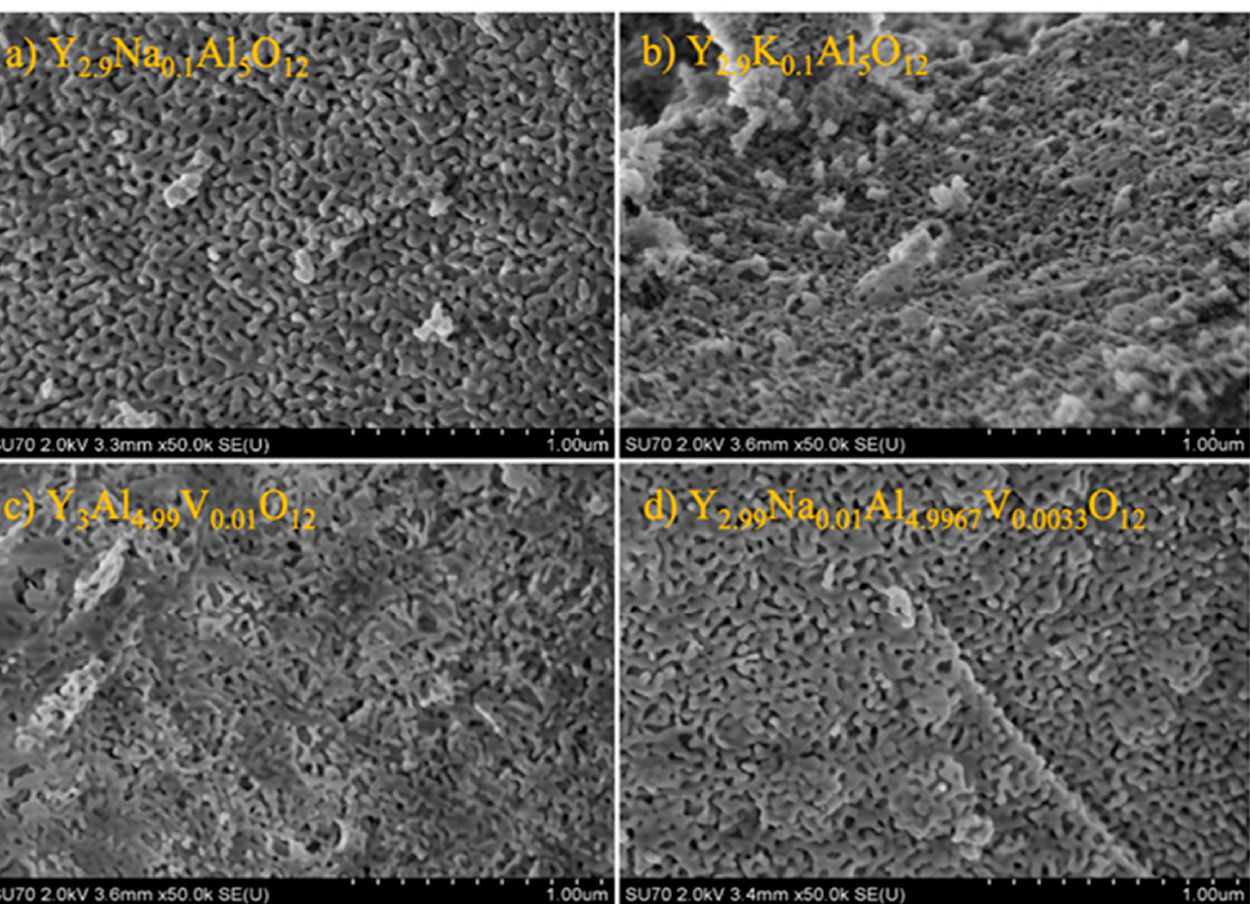
Figure 3. SEM micrographs of the Y 2.9 Na 0.1 Al 5 O 12 ( a ), Y 2.9 K 0.1 Al 5 O 12 ( b ), Y 3 Al 4.99 V 0.01 O 12 ( c ), and Y 2.99 Na 0.01 Al 4.9967 V 0.0033 O 12 ( d ) garnets synthesized at 1000 °C. Y 2.99 Na 0.01 Al 4.9967 V 0.0033 O 12 ( d ) garnets synthesized at 1000 ◦